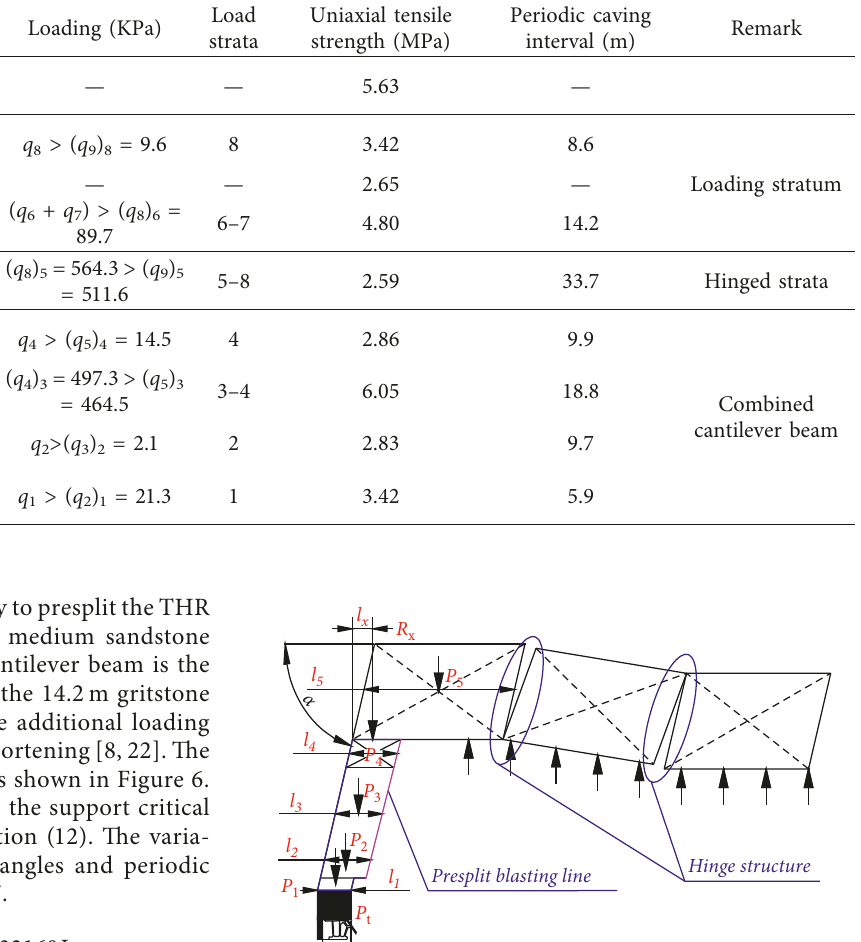
Table 1: Characteristics of strata loading and caving